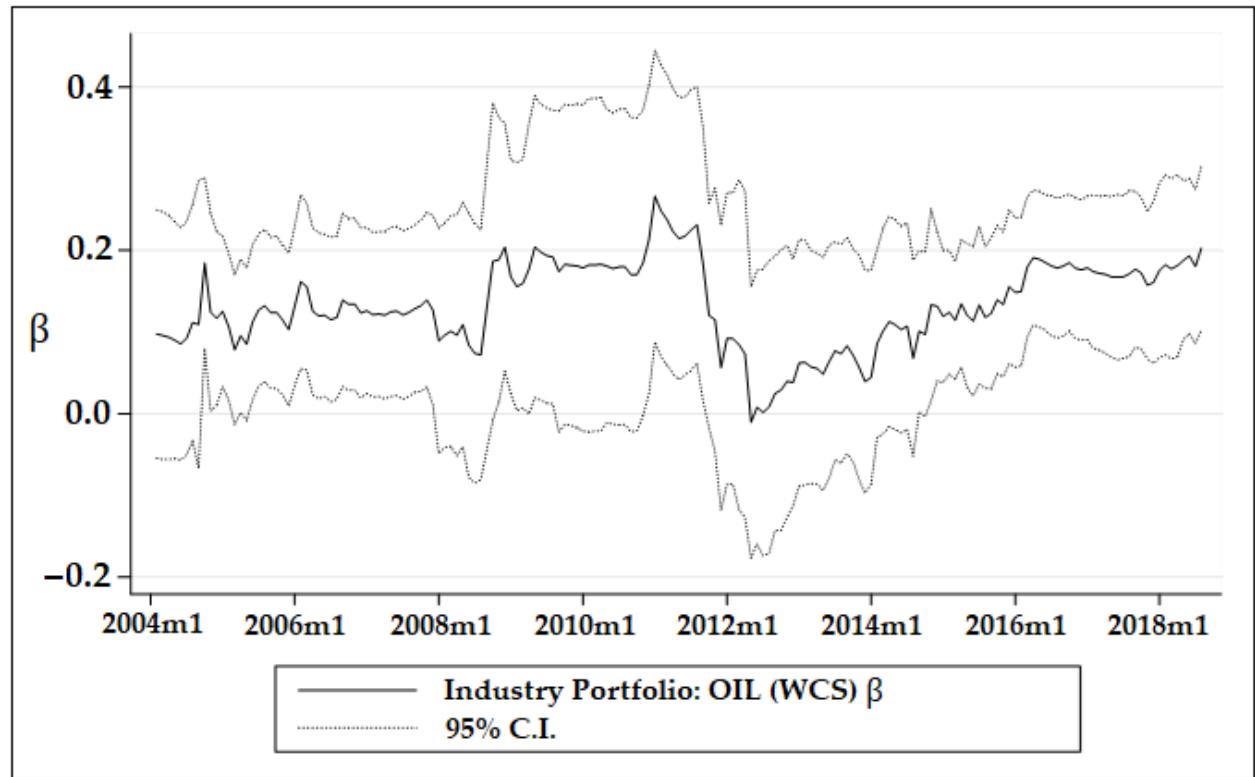
Figure 2. Time varying oil price beta (36-month average ( Δ WTI)).